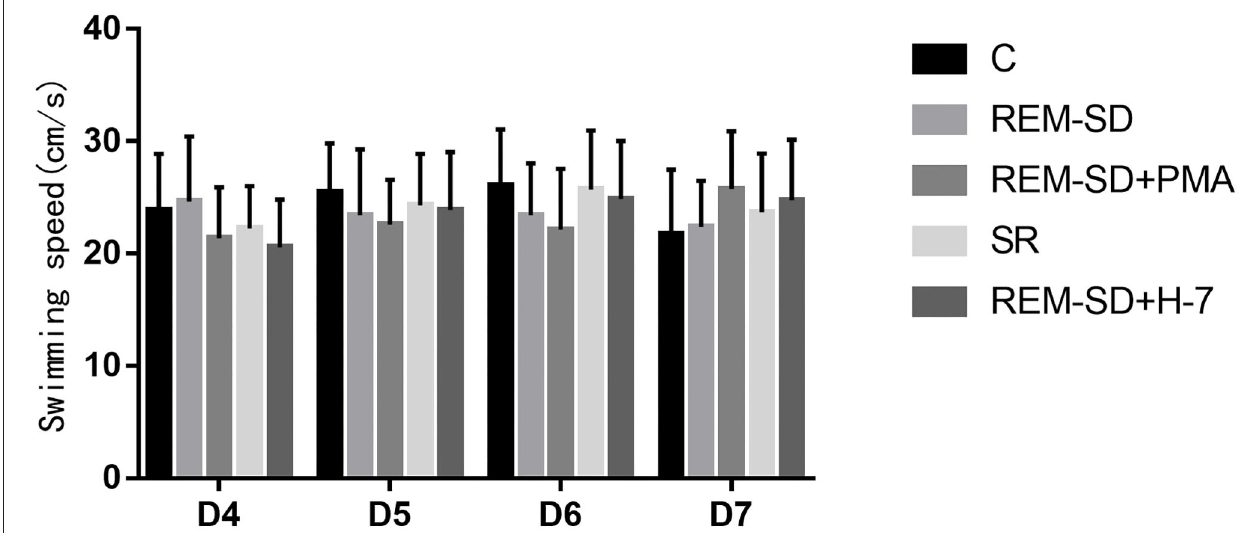
FIGURE 4 | The average swim speed (cm/s) on the Morris water-maze test for each group. No significant difference was found between the five groups with regard to the average swimming speed on the Morris water-maze